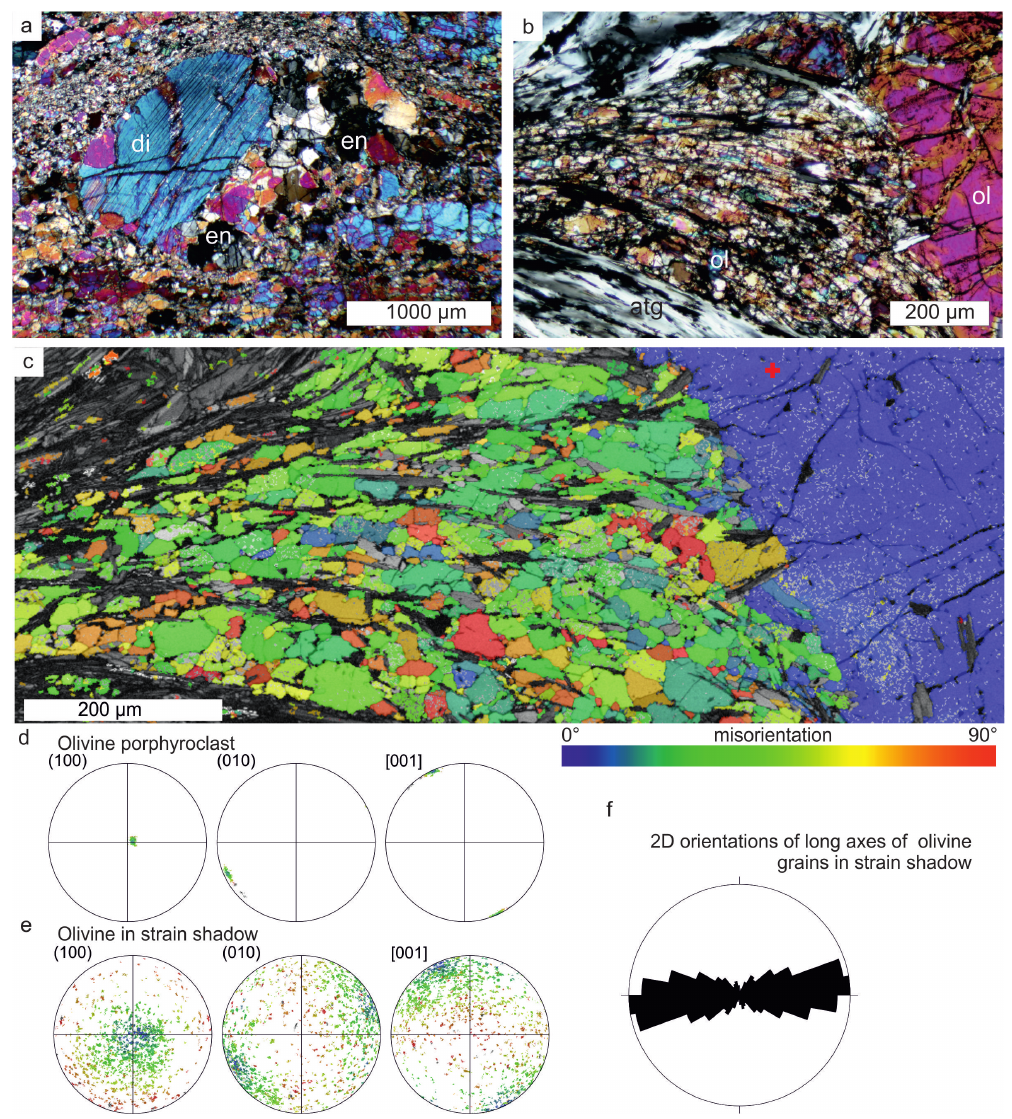
Fig. 7. (a) Polarized light micrograph (crossed polarizers) showing enstatite (en) in strain shadow around a diopside (di) porphyroclast (sample CT_07-19). Note that the new pyroxene grains in the strain shadow do not show exsolution lamellae. (b) Polarized light micrograph (crossed polarizers) showing olivine (ol) in strain shadow around olivine porphyroclast (sample CT_07-14). (c) EBSD map and corresponding pole figures of poles to (100), (010) and (001) planes of (d) olivine porphyroclast and (e) olivine in strain shadow. (f) Shape preferred orientation of olivine grains in strain shadow with long axes of grains in the foliation plane.